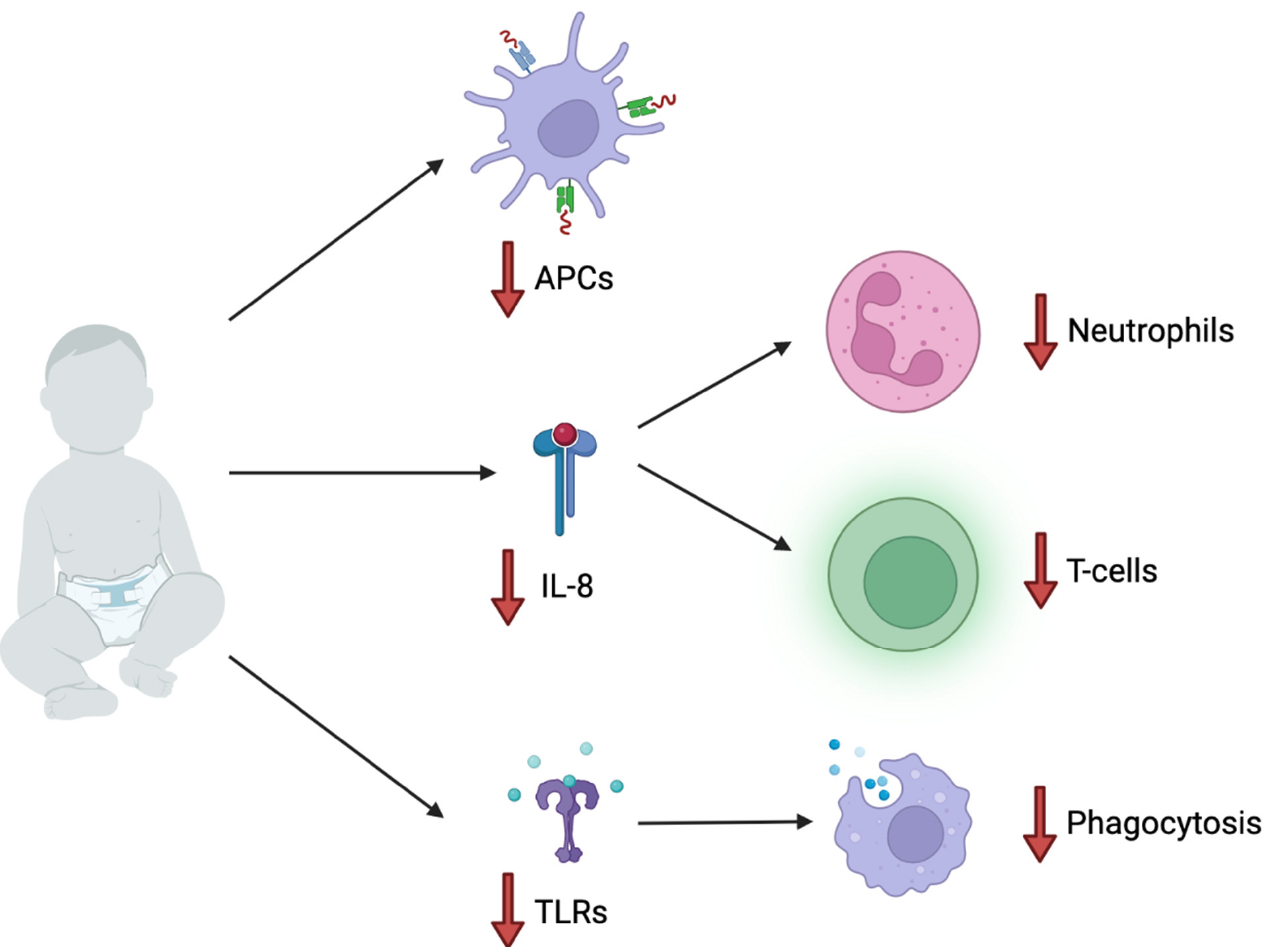
Figure 1. Infants are more susceptible to acquiring TB due to an immature immune system, including reduced antigen-presenting cells (APCs), reduced IL-8 chemokine production leading to impaired chemotaxis of neutrophils and T-cells, reduced toll-like receptors (TLRs), and, therefore, decreased phagocytosis for fighting infection.